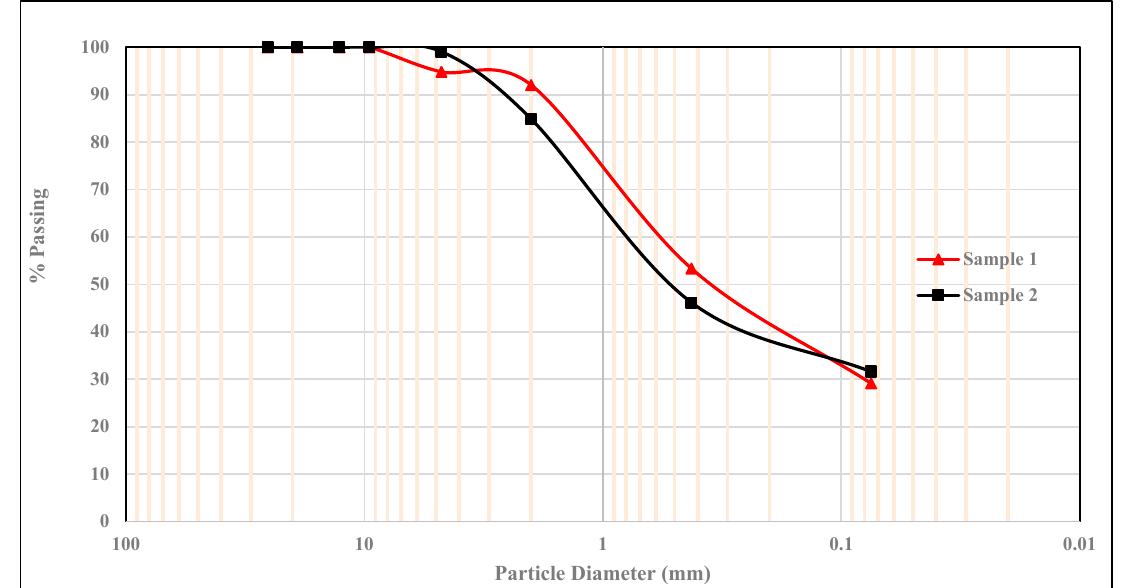
Figure 5. Sieve analysis of soil sample.